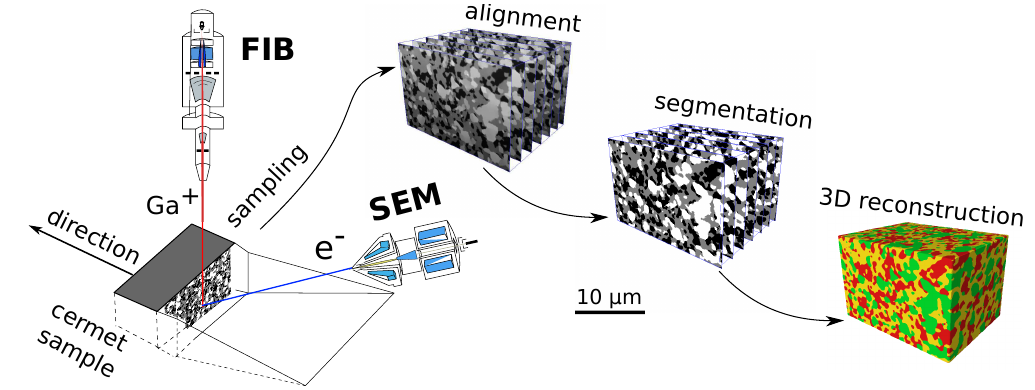
Figure 1. Virtual reconstruction of the microstructure morphology using the FIB-SEM tomography